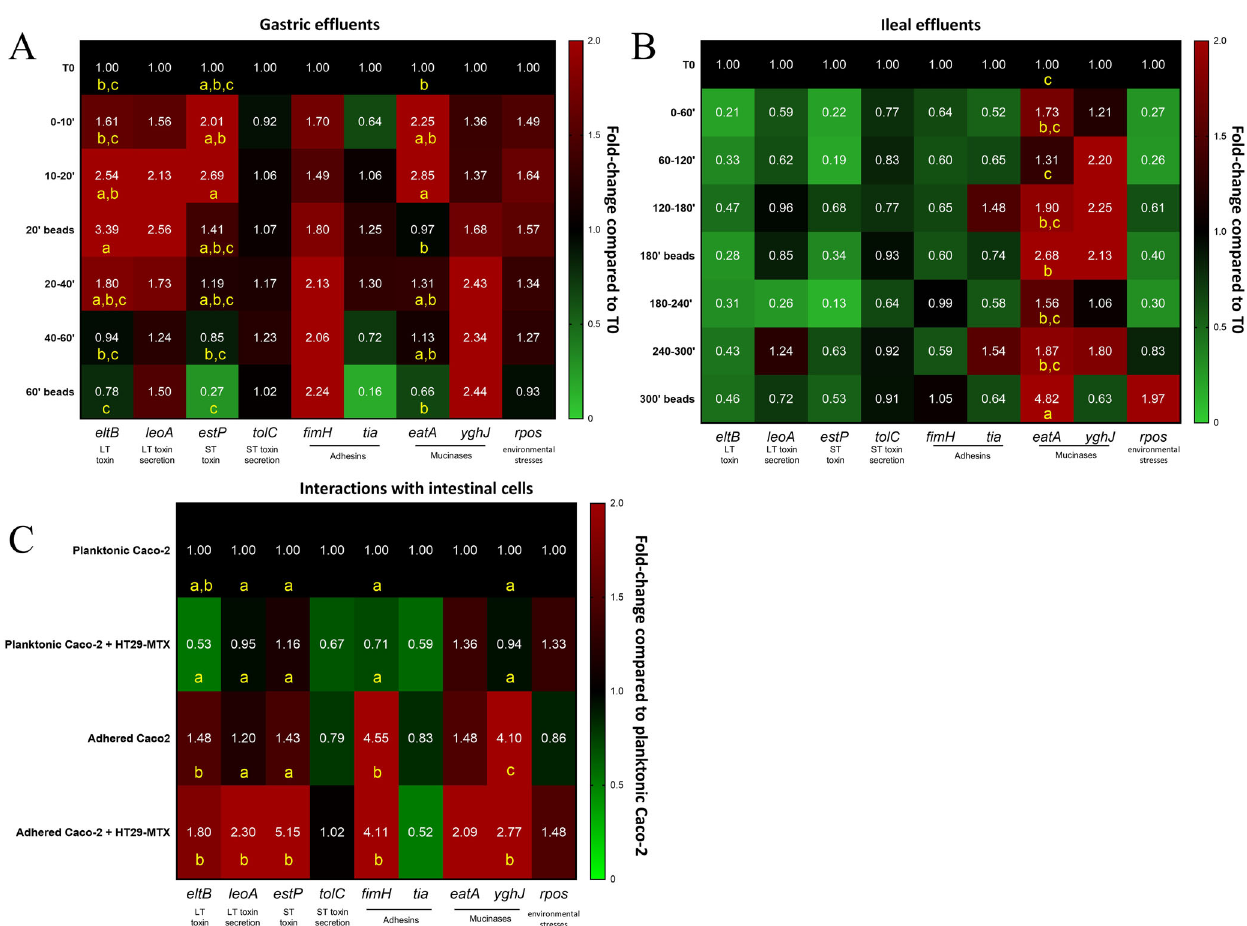
Fig. 2 Dynamics of ETEC survival and adhesion to mucin in the successive TIM-1 compartments. A – D After introduction of a glass of ETEC- contaminated water (10 10 CFU) in the TIM-1 model, the number of ETEC bacteria in the lumen ( “ planktonic ” bacteria) of stomach ( A ), duodenum ( B ), jejunum ( C ) and ileum ( D ) compartments was determined by plate counting. Results are expressed as mean percentages ± SEM ( n = 4) of initial intake. Bacterial survival kinetics with (orange dots) and without (black dots) mucin are compared with an inert and non- absorbable transit marker indicating 100% survival (blue dots). The evolution of pH in each compartment is also indicated with (orange star) or without mucin (black star). Indicated p value correspond to times at which the survival in the mucin condition was found to be statistically different from the non-mucin condition according to Sidak multiple comparison tests (* p < 0.05; ** p < 0.01; *** p < 0.001). E, F ETEC adhesion to mucin-alginate beads was also analyzed by sampling and plating at different time points in each compartment of TIM-1. Results are expressed